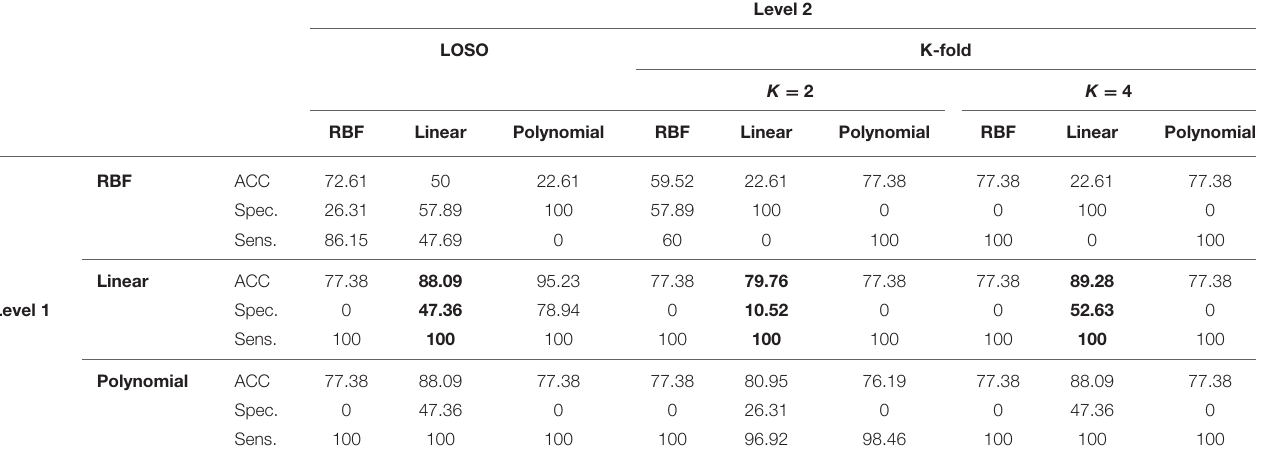
Level 2 LOSO K-fold